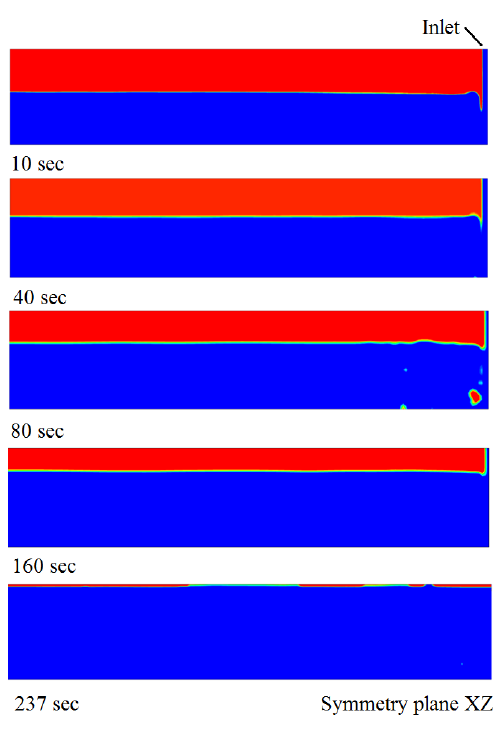
Figure 4. Variation of melt bath height in reduced scale tundish.